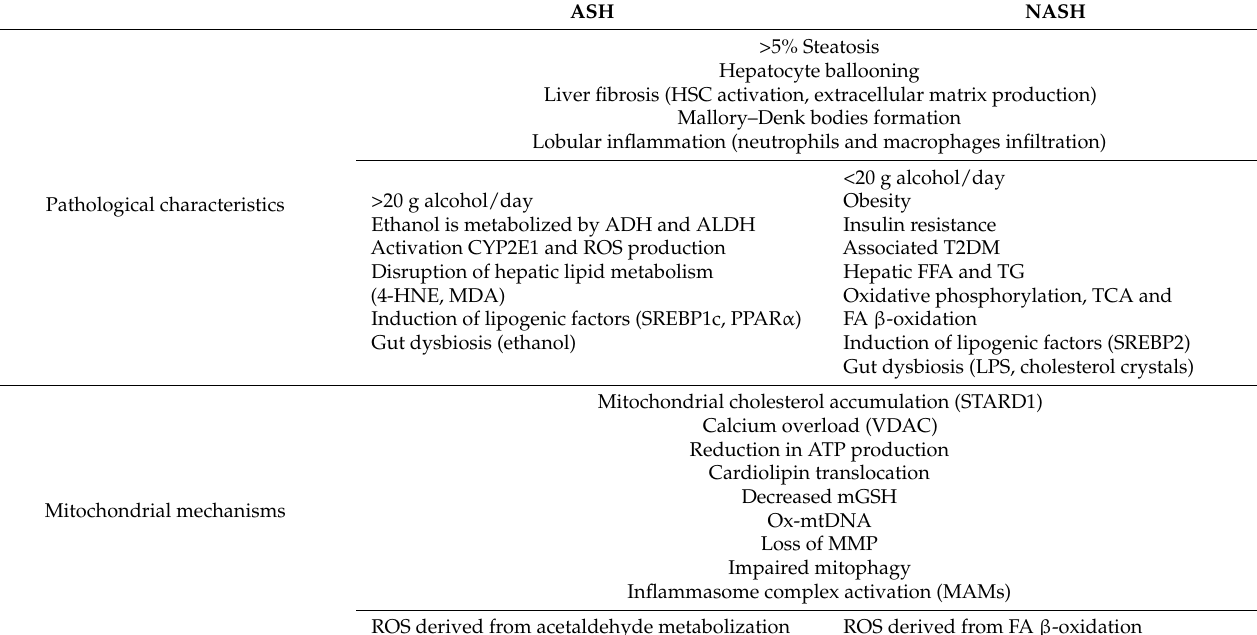
Table 1. Comparison of pathological characteristics and mitochondrial mechanisms in ASH and NASH. ASH NASH